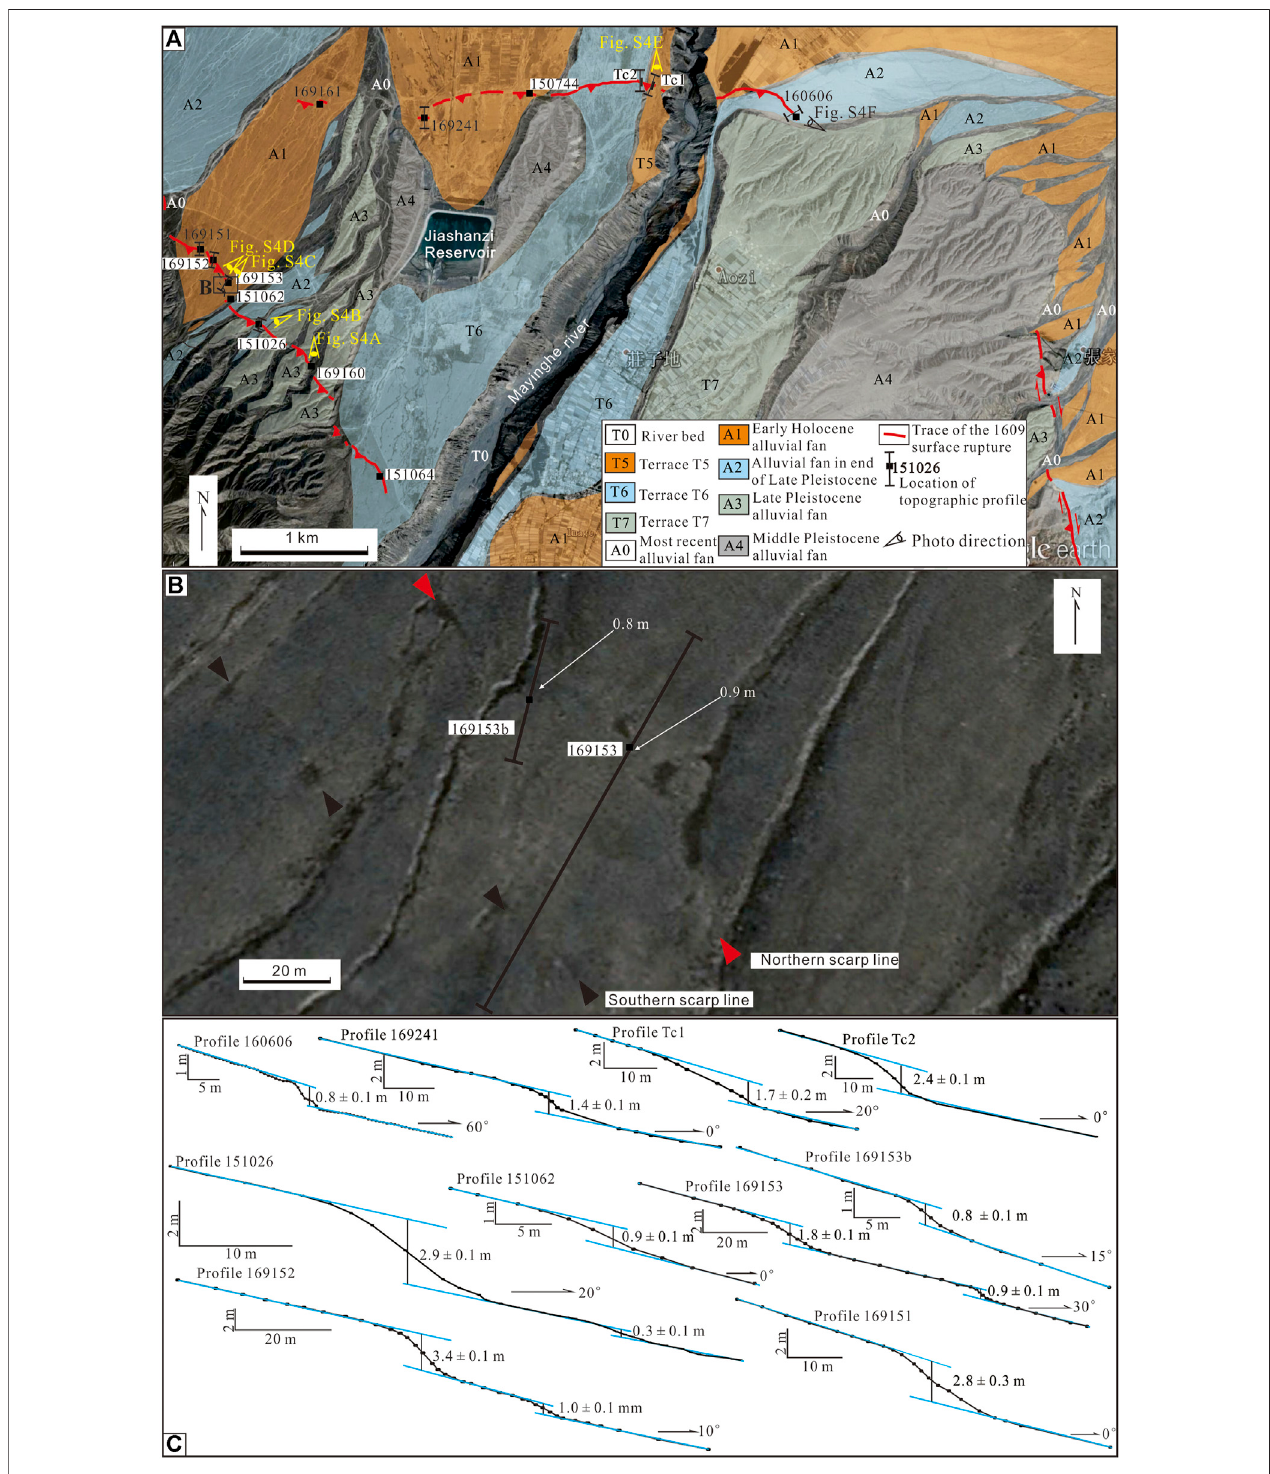
FIGURE9| Topographicfeaturesofthe1609earthquakesurfaceruptureontheMingyingRiversite. (A) Surfacerupturemap;theboxnearBshowsthelocationof Figure B . (B) Detailed remote-sensing image from Google Earth showing the trace of the shifting scarps at point 169,153, SW of Jiashanzi. (C) Topographic pro fi les across portions of 1609 rupture traces.